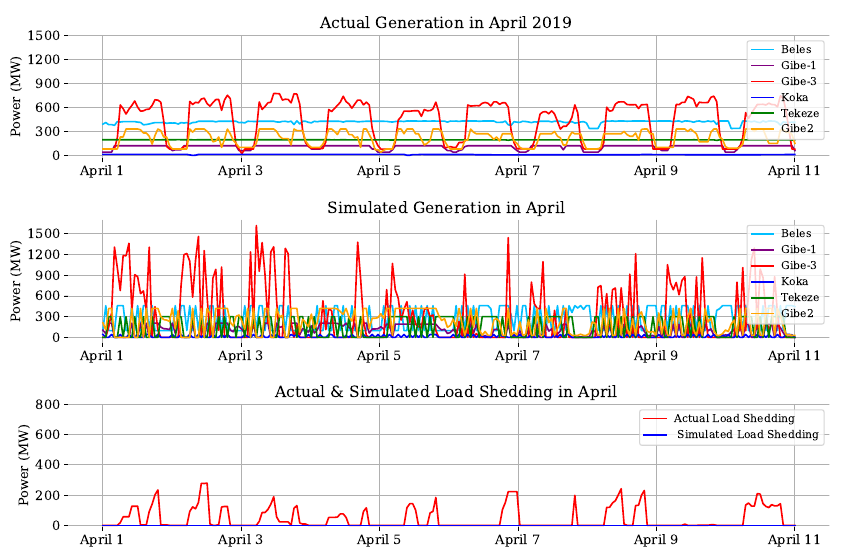
Figure 13. Actual and simulated load shedding and generation schedule for sample reservoirs in